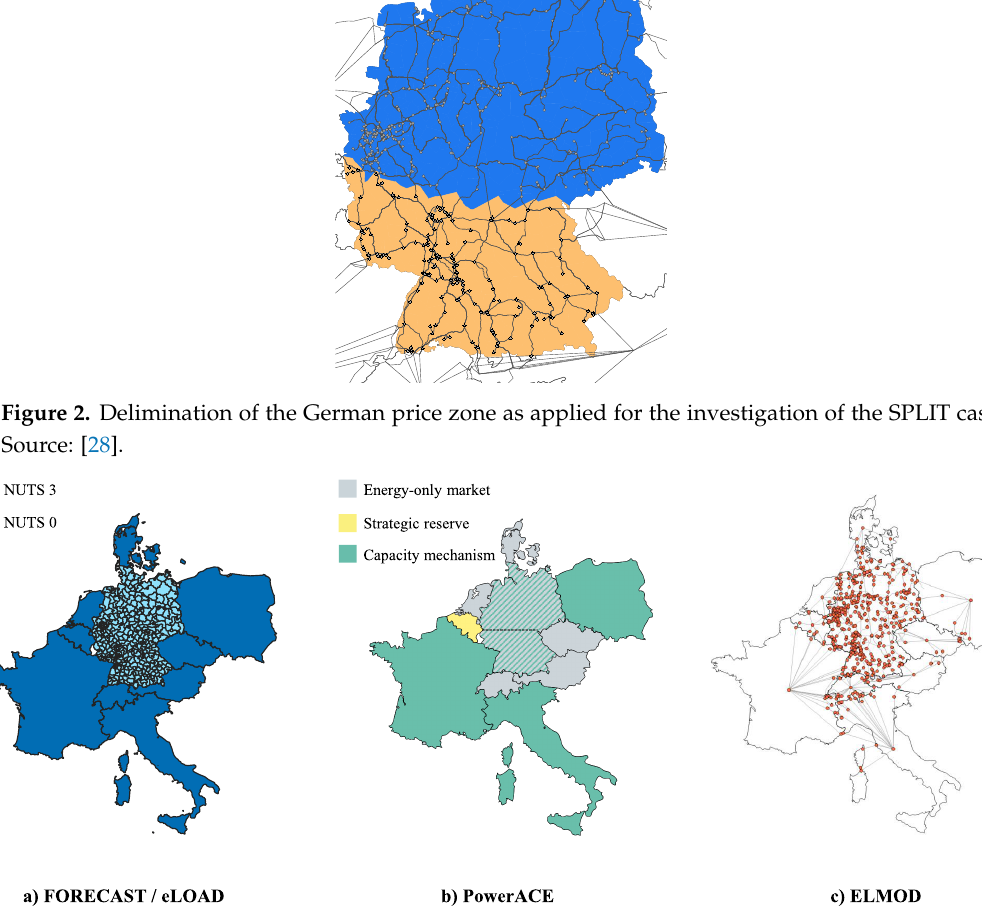
Figure 3. Geographical resolution of the different models applied and assumptions regarding the implemented market designs in the different